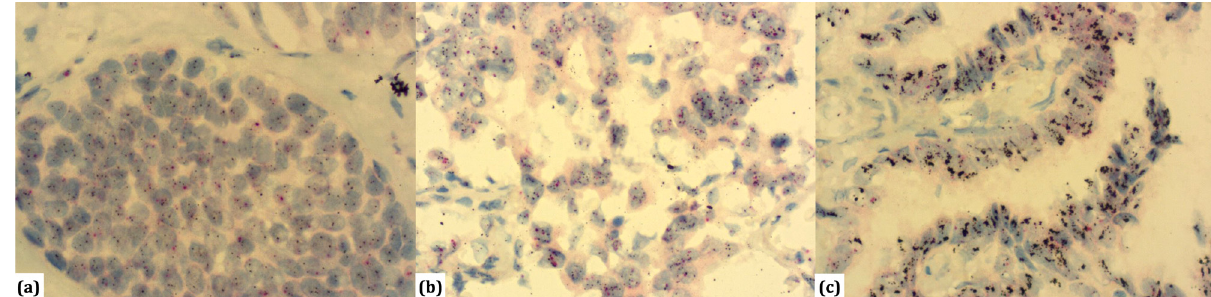
Figure 3: SISH method for detection of HER2 gene ( black label ) and CEP17 ( red label ) in lung adenocarcinoma: ( a ) HER2 / CEP17 ratio < 2.0 with an average HER2 copy number < 4.0 signals/cell - absence of HER2 ampli fi cation, (× 600 ) ; ( b ) HER2 / CEP17 ratio ≥ 2.0 with an average HER2 copy number ≥ 4.0 signals per cell – positive ampli fi cation HER2 gene (× 600 ) ; ( c ) tumours harboring an average copy number of ≥ 10.0 signals/cell - high - level ampli fi cation HER2 gene (× 600 )